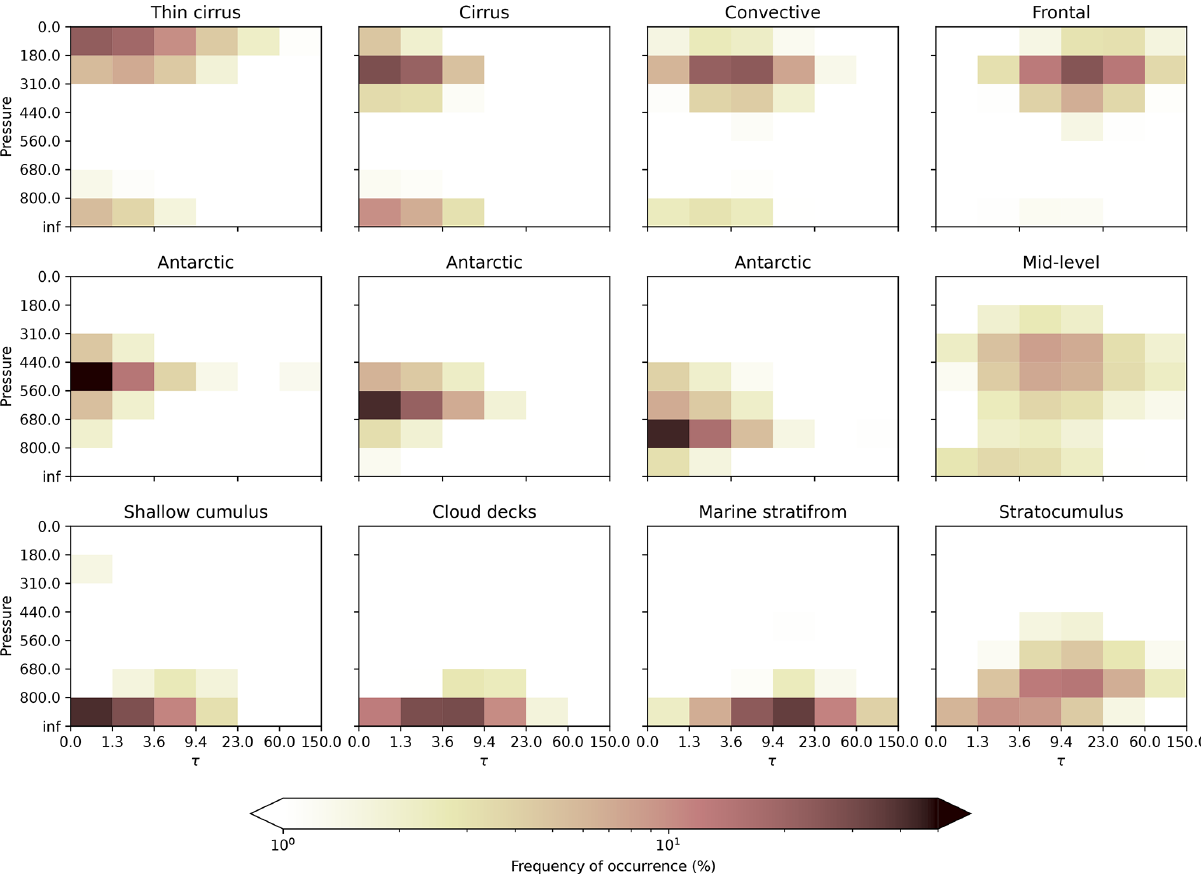
Figure 2. The mean CTP ( y axis, hPa)– τ ( x axis, optical depth unitless) histograms for each cloud regime found by k -means clustering on the MODIS product (daily means, 2015–2019). Each histogram has been assigned a “cloud type”. The histograms have been loosely arranged by pressure and